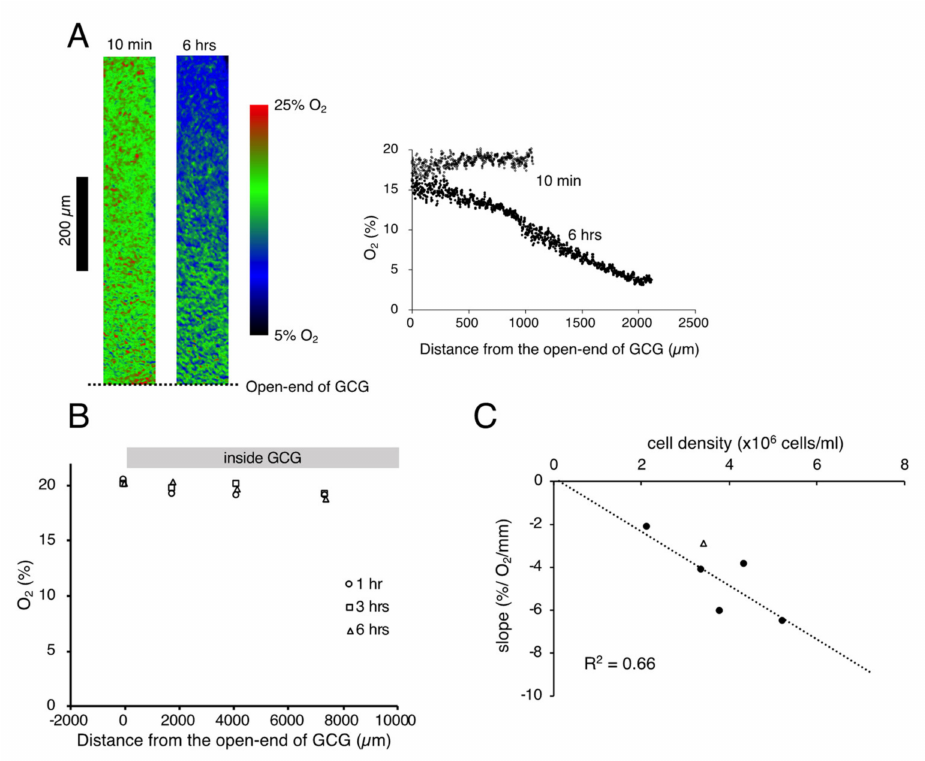
Figure 1. ( A ). Representative data indicating changes in oxygen concentration in the extracellular medium along the oxygen di ff usion path as measured by the oxygen sensor foil. The ratio of red and green fluorescence is represented in pseudo-color. At 10 min after placing the gap cover glass (GCG), no gradient was demonstrated underneath. At six hours after placing the GCG, a − 6.2% O 2 / mm linear oxygen concentration gradient was produced under the GCG. The number of MDA-MB-231 cells in the culture dish was 5.2 × 10 6 cells / mL. Note that the oxygen concentration at the opening of the GCG (distance = 0) was substantially lower than that in the microincubator (21%), probably due to the existence of an oxygen di ff usion barrier in the bulk medium as suggested by Metzen et al. [14]. ( B ) E ff ect of mitochondrial respiratory complex III inhibitor (antimycin A, 2 µ M) on the oxygen concentration gradient. Elimination of mitochondrial respiration abolished the oxygen concentration gradient under